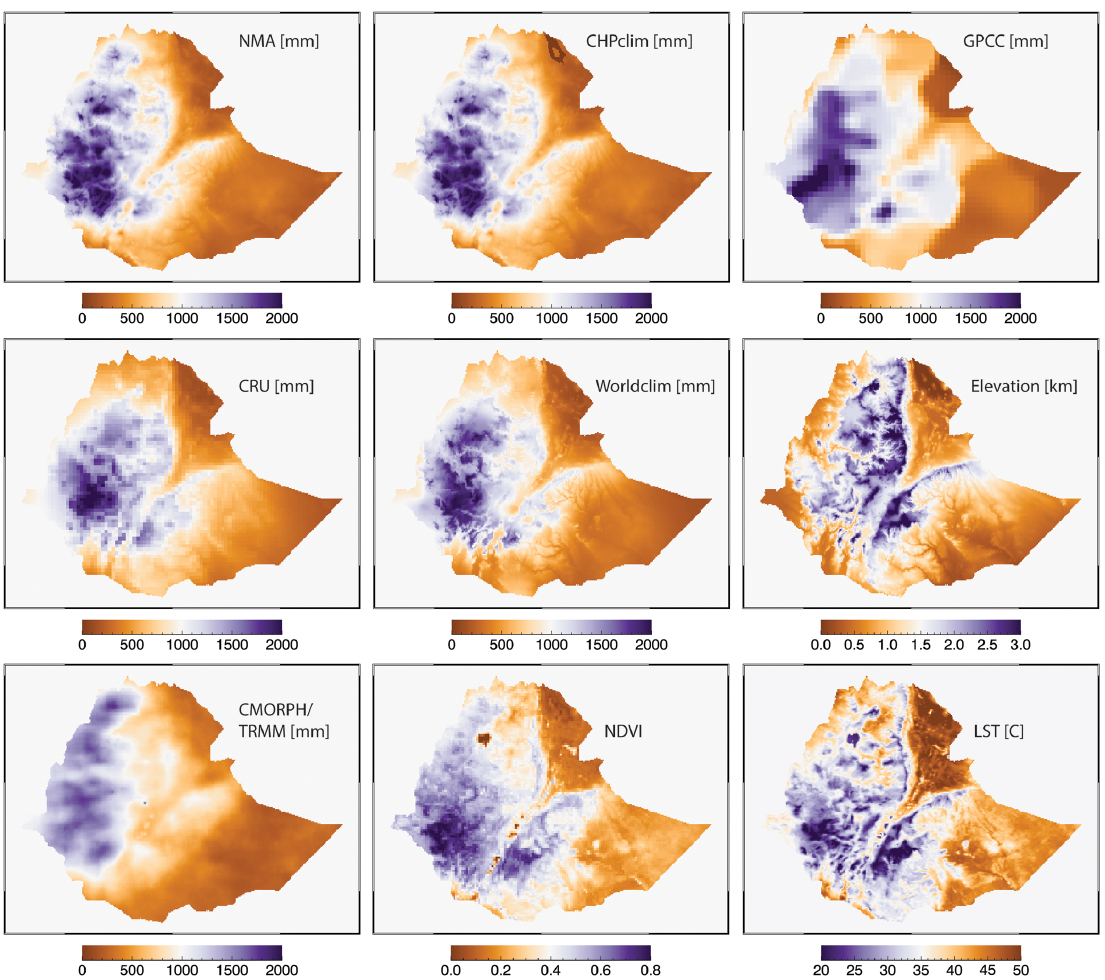
Figure 10. Total annual rainfall, elevation, NDVI and LST for Ethiopia. Rainfall totals are from the Ethiopian National Meteorological Agency (NMA), CHPclim, the GPCC M V2015 climatology, the CRU CL v2.0, the version 1.4 release 3 Worldclim climatology, and the blended CMORPH/TRMM data used in the CHPclim modeling